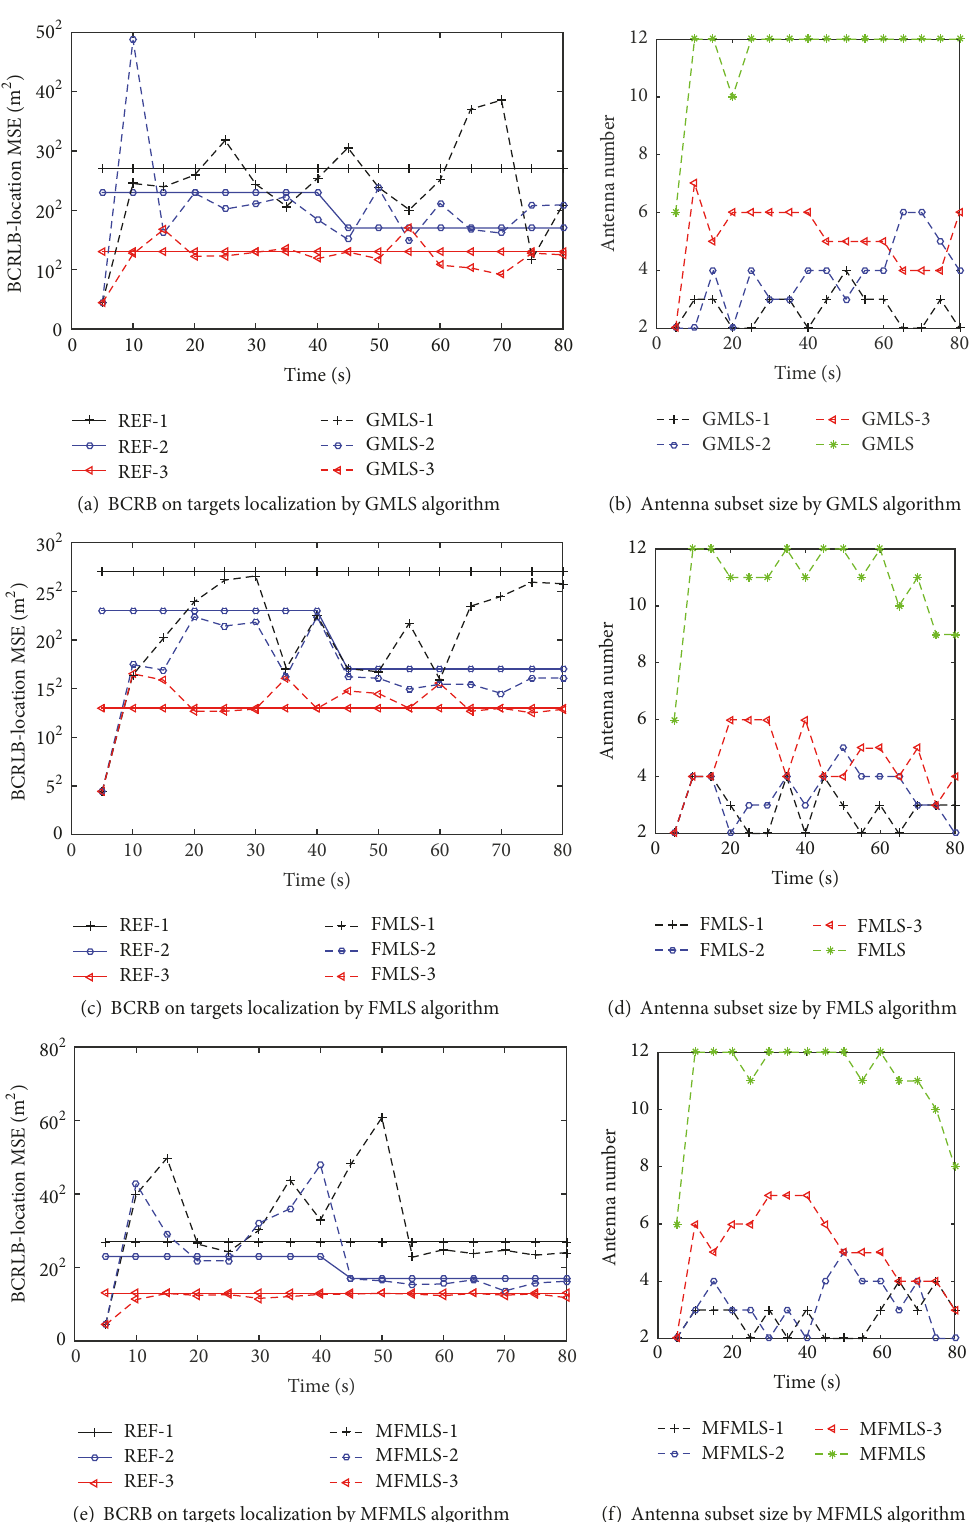
(e) BCRB on targets localization by MFMLS algorithm (f) Antenna subset size by MFMLS algorithm Figure 2: BCRB on targets localization and antenna subsets by different algorithms with high MSE